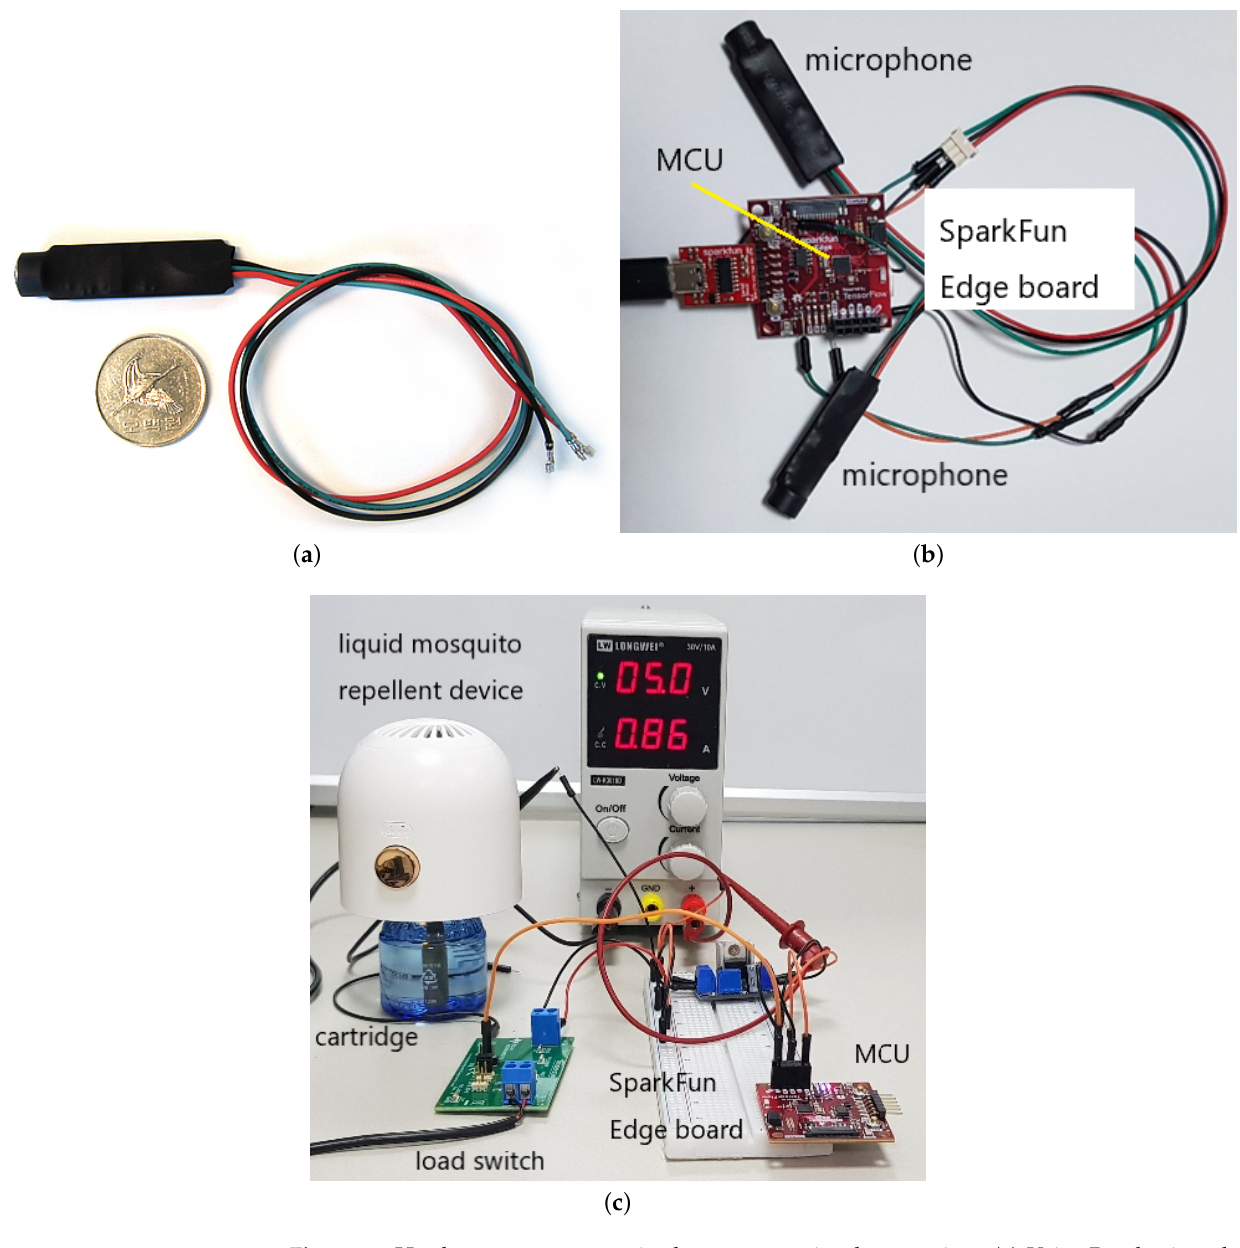
Figure 4. Hardware components in the prototype implementation: ( a ) Voice Band microphone amplifier module (KB100VC) [20] used by the prototype. ( b ) Test board with microphones connected. ( c ) Overall test configuration with a commercial electric liquid mosquito repellent and SparkFun Edge